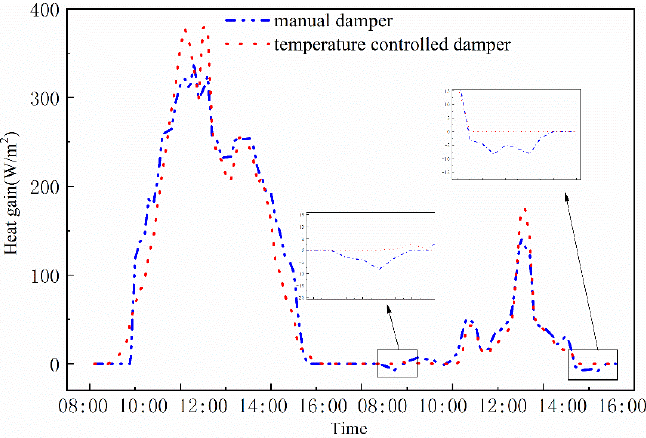
Figure 11. The heat gain comparison of different dampers.